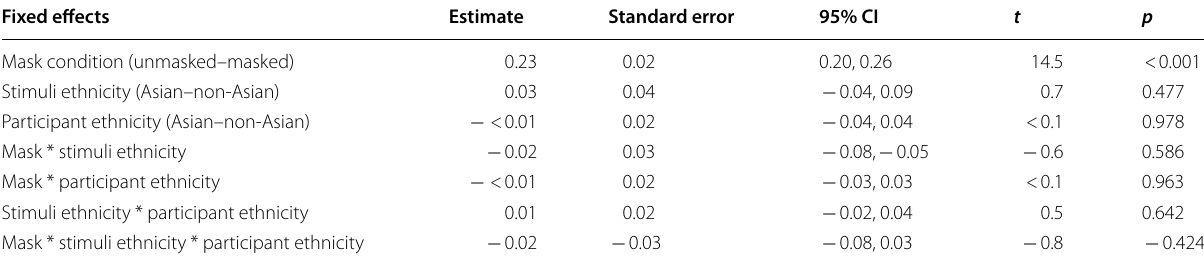
Table 4 Fixed effects table for the Asian ethnicity linear mixed effects model